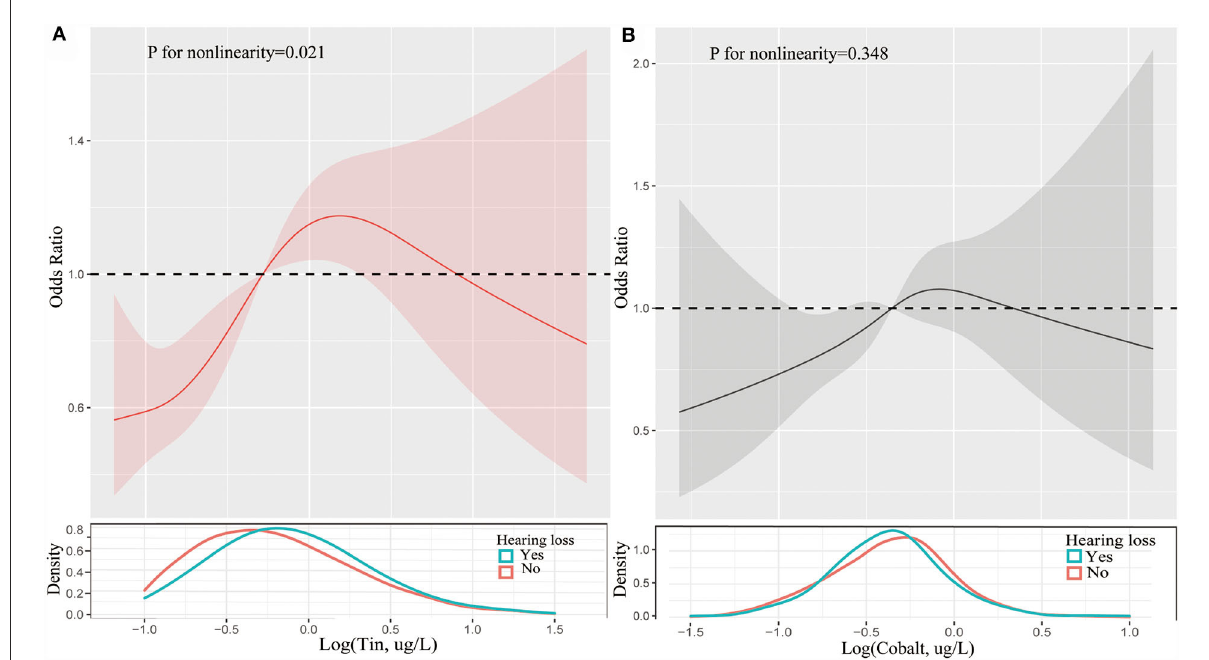
FIGURE1 Restricted cubic spline of association between the levels of tin (A) and cobalt (B) and the risks of hearing loss. Analyses were adjusted for age, gender, race, hypertension, diabetes, hyperlipidemia, noise exposure, triglyceride, total cholesterol and low-density lipoprotein cholesterol. The solid line and dashed line represent the log-transformed odds ratios and corresponding 95% confidence